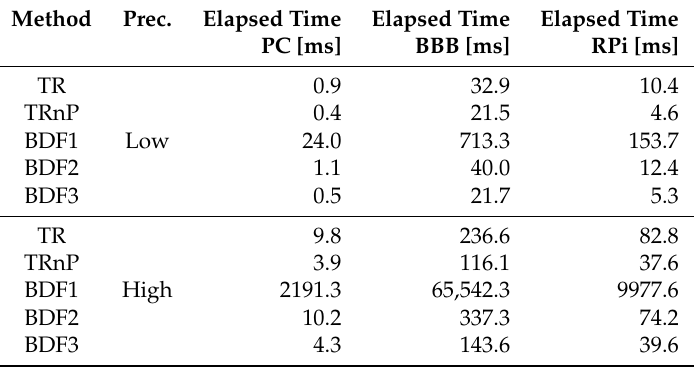
Table 12. Elapsed times in the simulation of the scalable RLC circuit ( N = 2 loops).